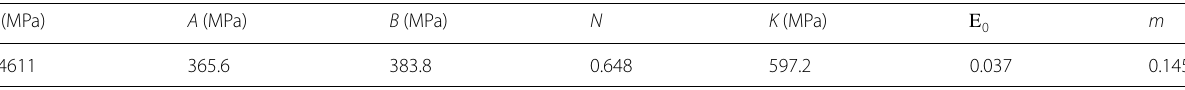
Table 2 Parameters required for the plastic